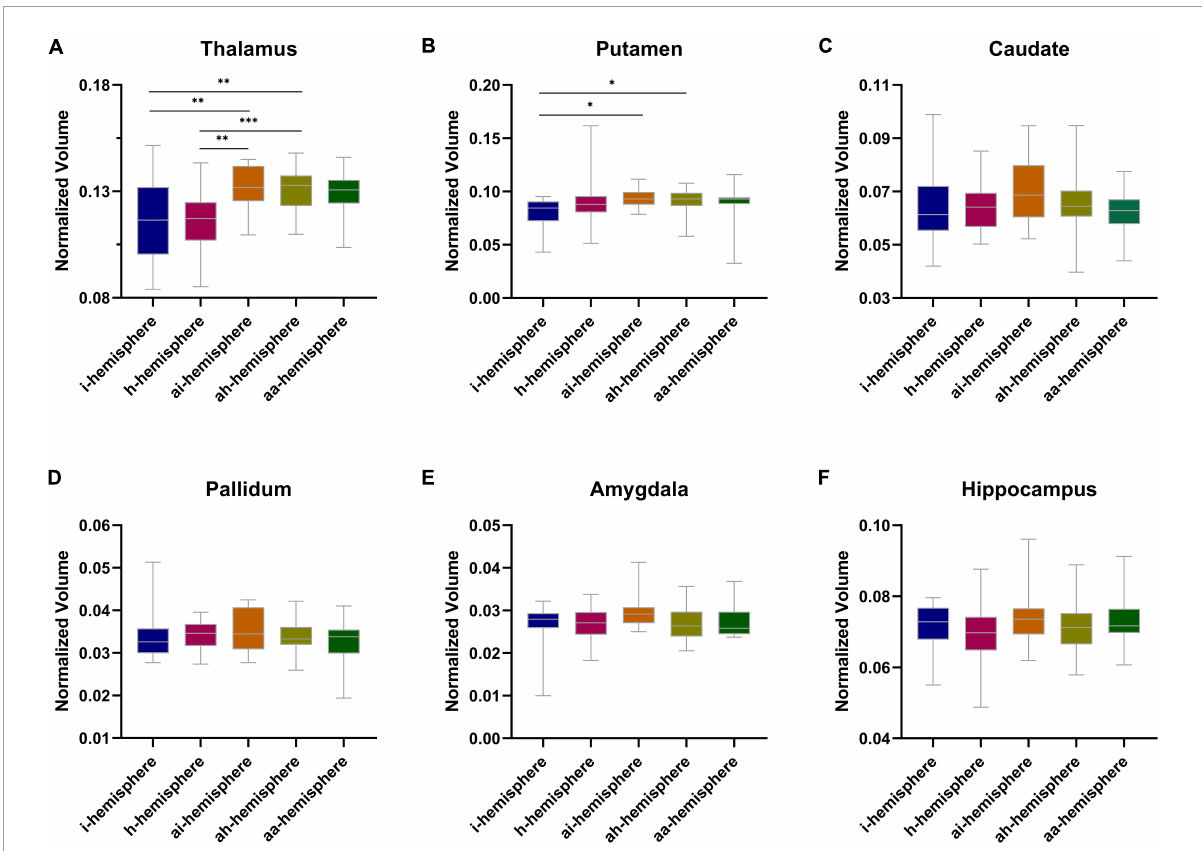
FIGURE3 (A–F) Normalized subcortical gray matter volume between different hemispheres in moyamoya disease (MMD). ∗ P < 0.05, ∗∗ P < 0.01, ∗∗∗ P < 0.001.